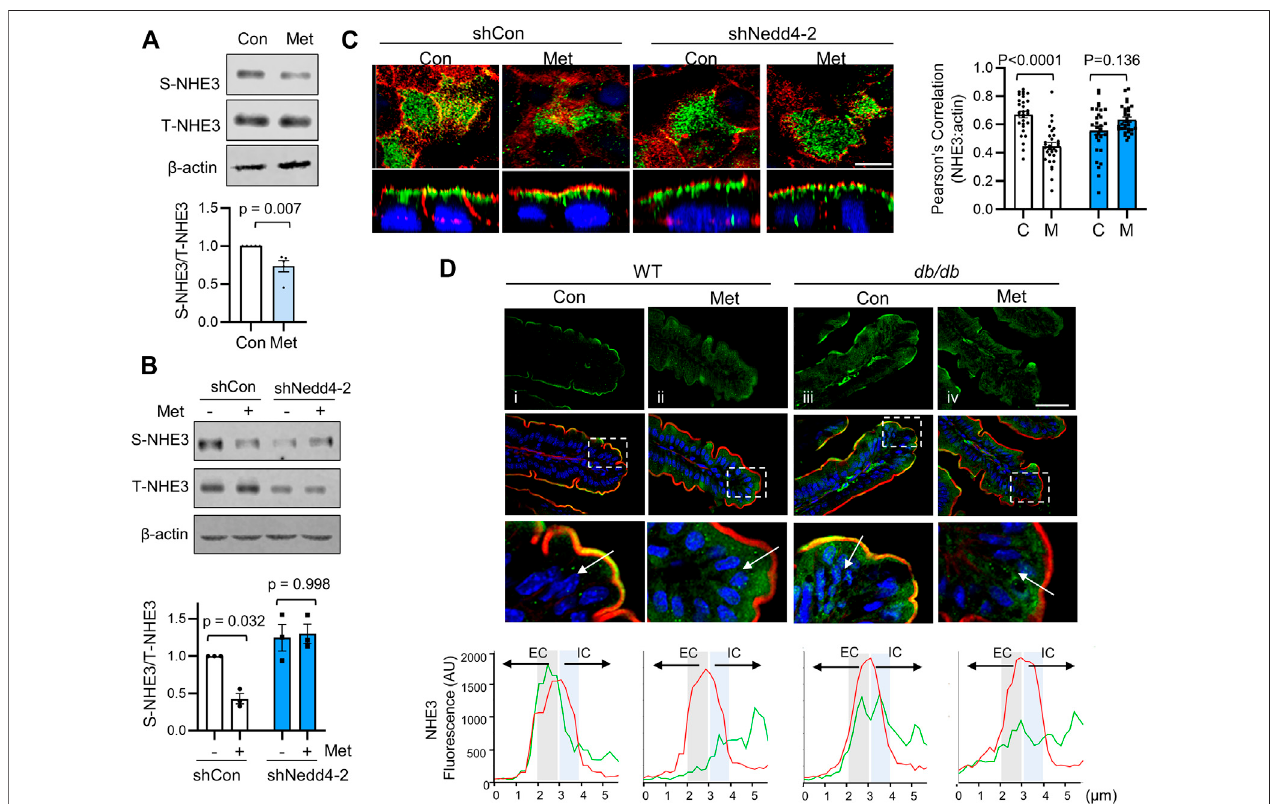
FIGURE5| MetformininducesinternalizationofNHE3. (A) NHE3expressionattheapicalmembraneofCaco-2bbecellstreatedwithmetforminwasdeterminedby surface biotinylation. The surface NHE3 expression was normalized to total NHE3 expression. The relative surface-to-total NHE3 ratios with the result in untreated cells set at 100% (mean ± SEM) are shown on the right. n = 5. (B) Apical membrane expression of NHE3 in cells transfected with shCon or shNedd4-2 was determined by surface biotinylation. (C) Caco-2bbe/NHE3 cells grown on Transwells were treated with metformin for 30 min. Top: horizontal (x – y) views at the cell surface. Bottom: cross-section (x – z) perpendicular to the confocal focal plane. Representative immuno fl uorescence labeling of NHE3 (green), actin (red, phalloidin), and nuclei (blue, DAPI) are shown. Two independent experiments with triplicates per group. Scale bar: 5 μ m. Graph on the right represents Pearson ’ s correlation coef fi cient of NHE3and ß -actinlocalizationfrom30independentvisual fi eldsisshown. (D) RepresentativeconfocalIFimagesofilealmucosashowingNHE3(green),F-actin(red),and nuclei (blue) from WT and db/db treated with metformin for 3 days. For each condition, four mice, fi ve sections/mouse examined. Scale bar: 5 μ m. Bottom panels show magni fi ed image of boxed area. Graphs below show representative fl uorescent intensity of NHE3 (red) and F-actin (green) along a line drawn perpendicular to the membrane. Actin was used as a relative marker to standardize fl uorescence intensity, with the peak of actin expression designated at the midway point across a 6 µm line. Extracellular (EC) and intracellular (IC) relative to